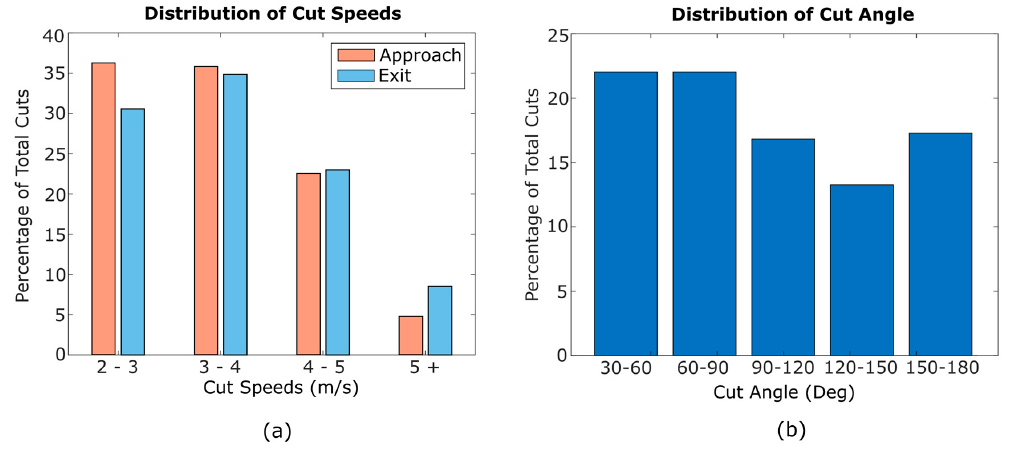
Figure 3. Histograms showing the distribution of cuts across speed ( a ) and cut angle ( b ).